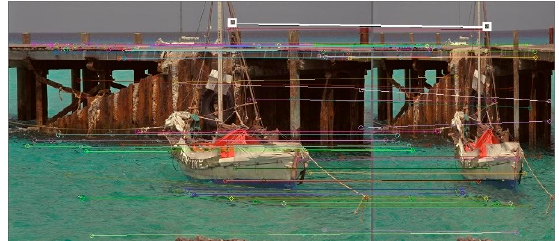
Figure 3. Calculating the similarity of the matching image block structure.